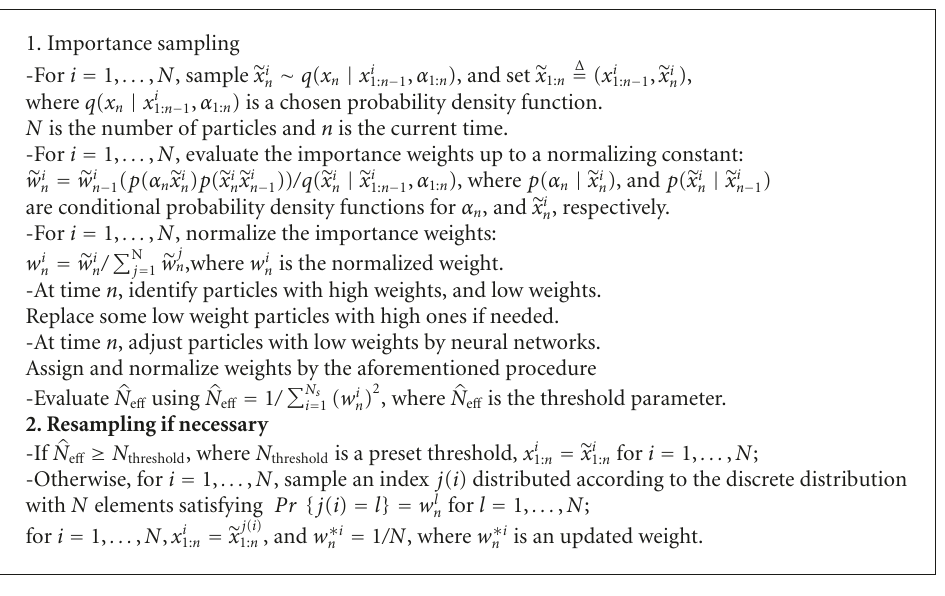
Algorithm 1: Importance sampling/resampling particle filter with a neural network.